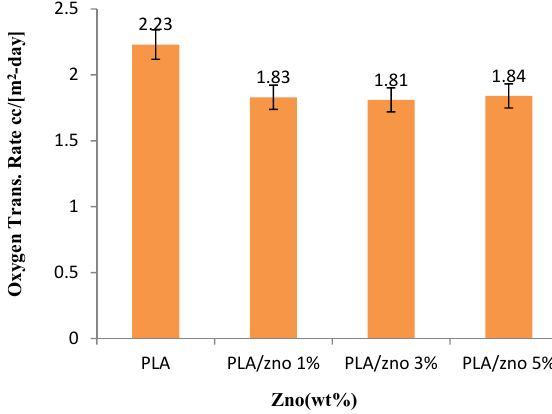
Fig. 4. Comparison of the effect of nano-zinc oxide addition with different percentages on oxygen permeability in poly-lactic acid film